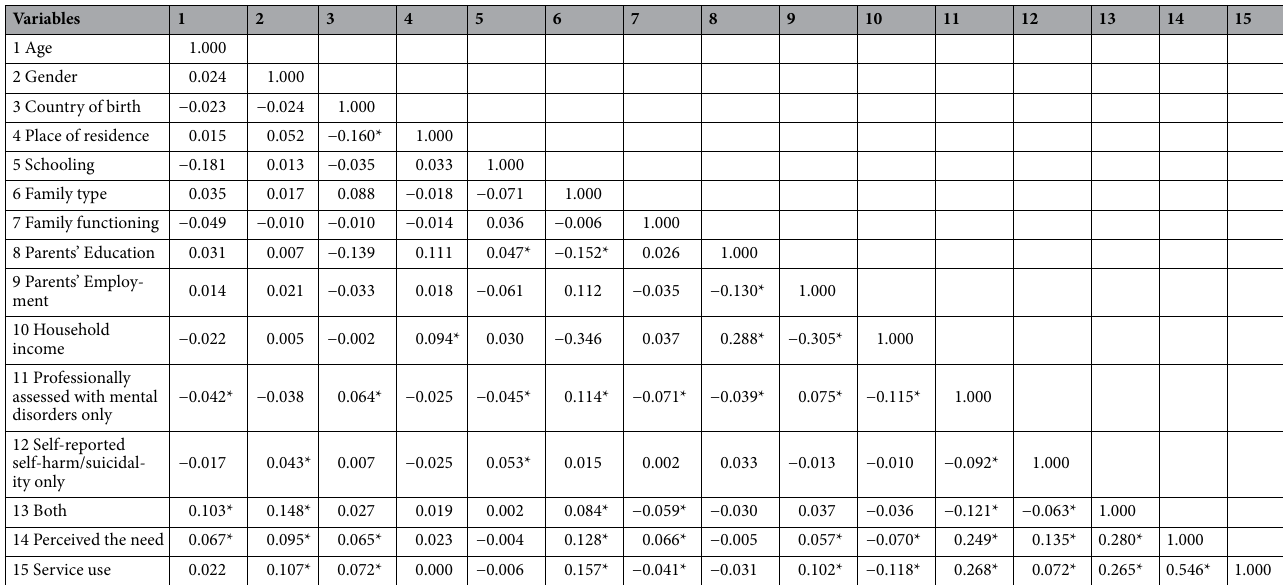
Table 3. Matrix of correlation among study variables. Total observations, n = 2464, * p < 0.05 considered